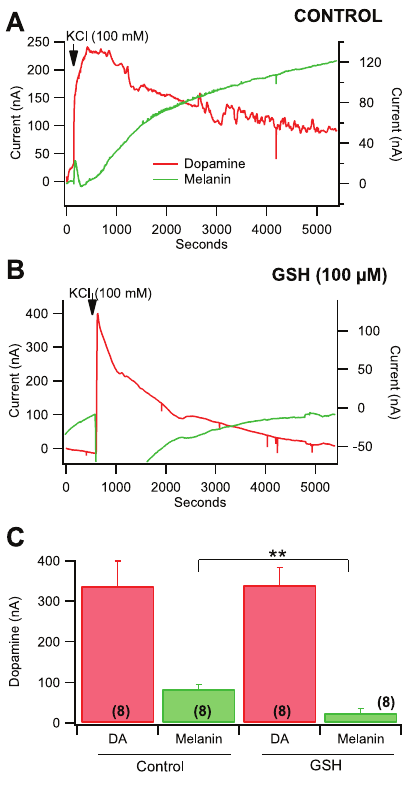
Figure 6. Fast-scan cyclic voltammetry of melanogenesis of DA in the NAc slice preparation ex vivo. ( A ) This graph shows the current over time for DA vs. melanin after depolarization of DA terminals in the NAc produced by infusion of 100 mM KCl into the closed system. ( B ) In this representative example, 100 µ M GSH reduced the formation of melanin by KCl but not the decay in DA over time, likely due to ongoing re-uptake of DA at DA terminals in the striatum. ( C ) Cumulative comparison of spontaneous melanogenesis as measured by FSCV. GSH significantly reduced DA melanogenesis. Significance marker ** denotes p < 0.01. Data is presented as mean ±